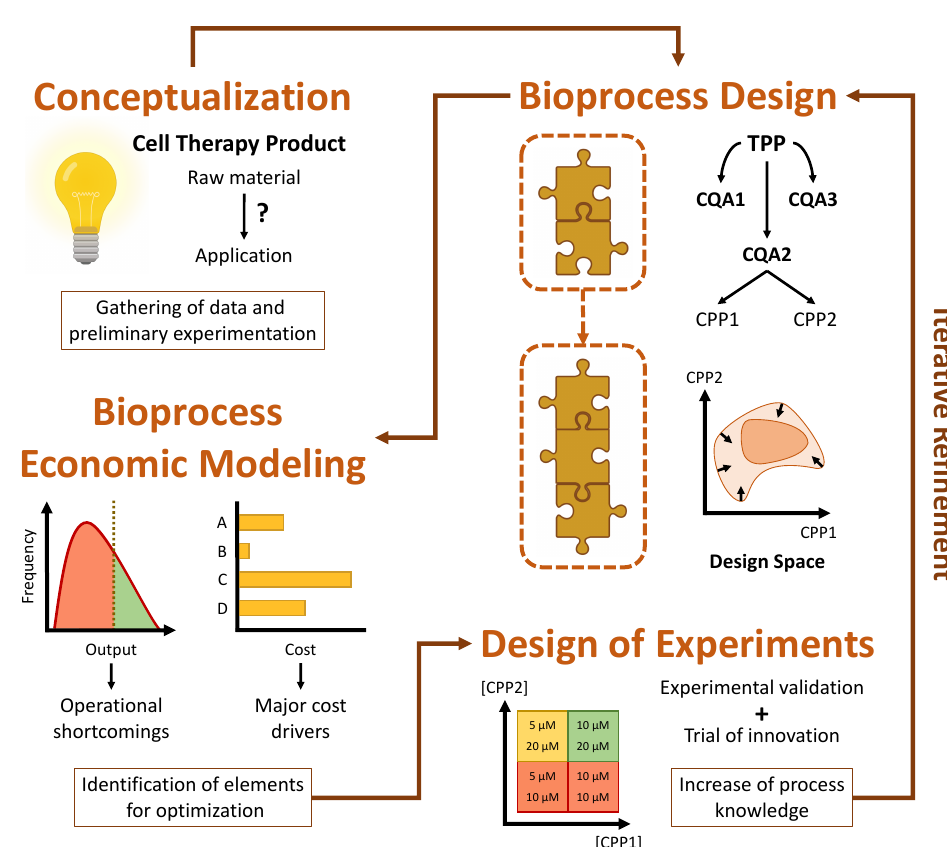
Figure 1. In the context of the quality by design framework, the development of a cell therapy product (CTP) begins with the conceptualization of a bioprocess that leads from cell-based raw materials to a product capable of fulfilling its envisaged application. It then moves on to the creation of a rough draft of the bioprocess, defining the CTP in terms of its target product profile (TPP), critical quality attributes (CQAs) and critical process parameters (CPPs). Based on the CPPs, a process design space is also delineated. Naturally, the initial rough draft is limited by a lack of process knowledge, but it provides a blueprint for future development. So as to guide the accrual of process knowledge, a bioprocess economic model (BEM) can be established to simulate the outlined bioprocess, serving as a useful tool for swiftly and inexpensively identifying those elements whose optimization would bring the most benefit to the bioprocess in terms of quality or cost. Once these have been identified, directed experimentation should be carried out following a methodical design of experiments